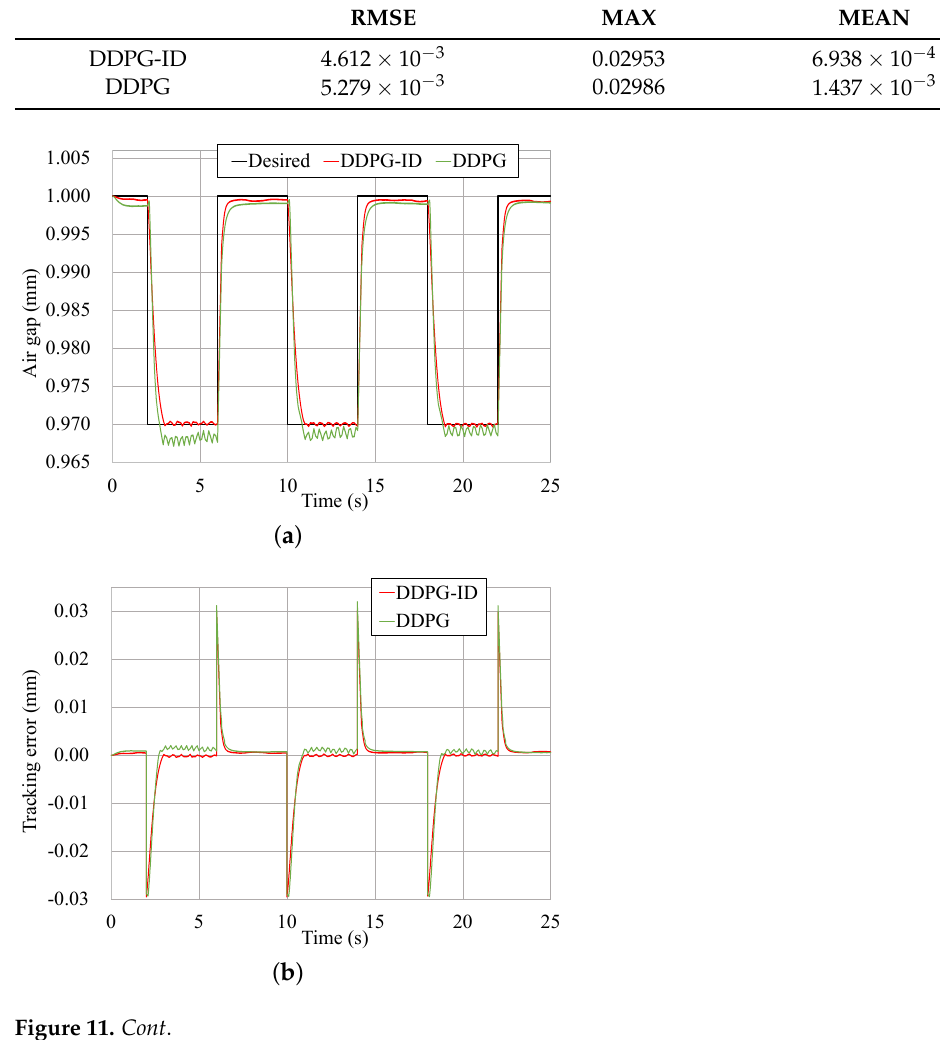
Table 8. Tracking errors comparison of different controllers in the step trajectory.